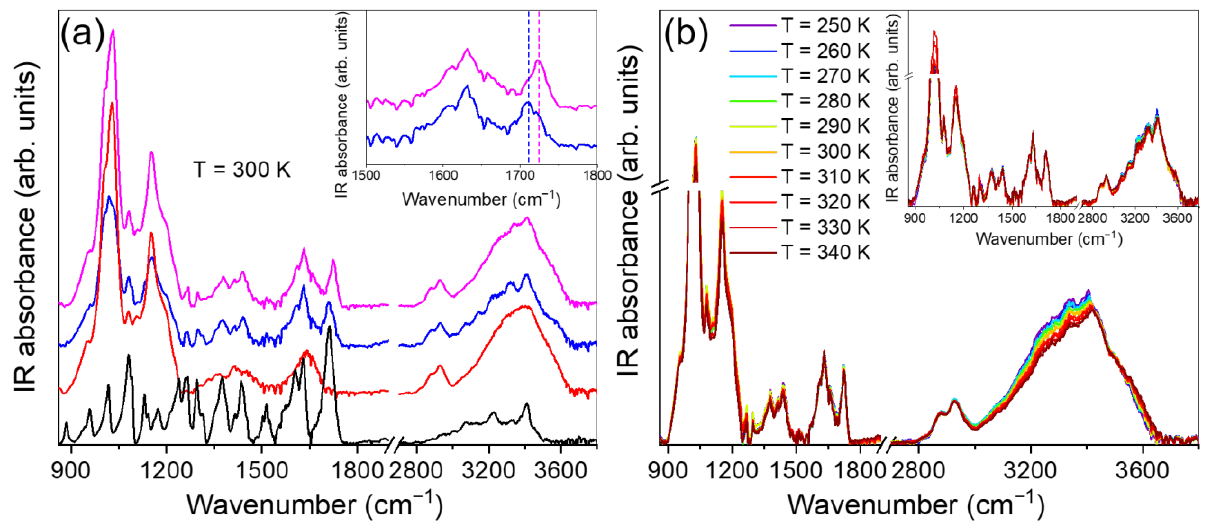
Figure 2. ( a ) Experimental 1D FTIR-ATR spectra, collected in the 850–3800 cm −1 wavenumber range at T = 300 K, of Coum (black line), SBE-β-CD (red line), Coum+SBE-β-CD physical mixture (blue line) and Coum/SBE-β-CD inclusion complex (purple line). In the inset, a comparison between the FTIR-ATR spectra of Coum+SBE-β-CD physical mixture (blue line) and Coum/SBE-β-CD inclusion complex (purple line) is displayed in the 1500–1800 cm −1 region, where the characteristic C=O stretching vibration of Coum (~1710–1725 cm −1 ) falls. ( b ) Evolution versus T , in the 850–3800 cm −1 wavenumber region, of Coum/SBE-β-CD inclusion complex and, in the inset, Coum+SBE-β-CD physical mixture 1D FTIR-ATR spectra.